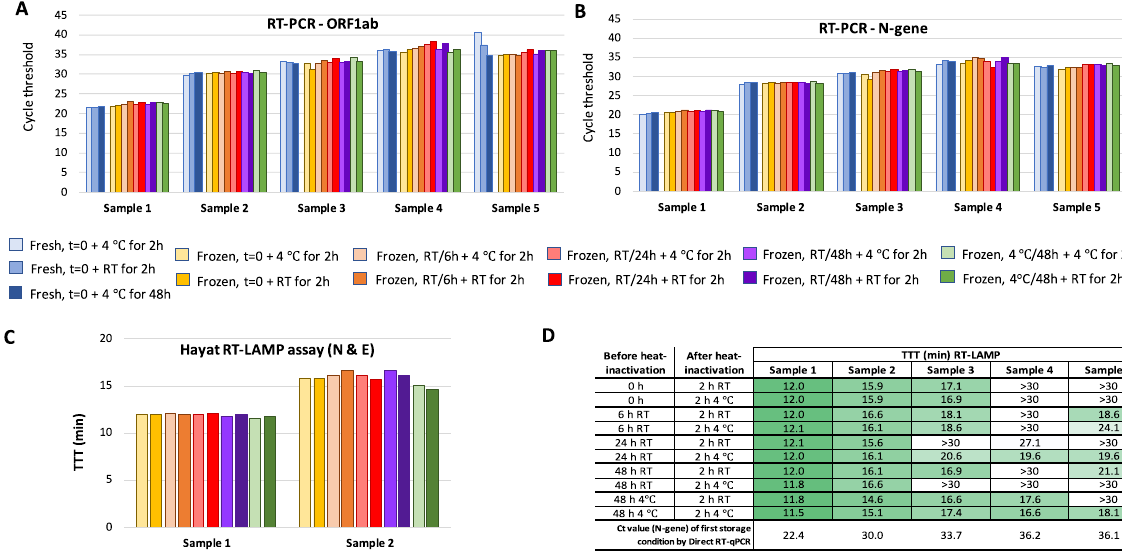
Figure 3. Stability of saliva samples during short-term storage determined by RT-PCR and RT-LAMP. Five sample pools were prepared from ten saliva samples to give a range of viral loads corresponding to predicted Ct values (from extracted RNA) from 24.6 to 35.0 for the N-gene and 25.8 to 39.1 for ORF1ab. Sample pools were diluted with an equal volume of AviSal buffer and stored short-term under the following test conditions prior to heat inactivation: room temperature (RT) for 0, 6, 24 and 48 h (t = 0, 6 h, 24 h and 48 h) or 4 °C for 48 h. Samples were then heat inactivated at 95 °C for 10 min and frozen. Upon thawing, samples were stored post inactivation at either 4 °C or RT for 2 h or 4 °C for 48 h (t = 0 only). The 4 °C incubation was taken as baseline as a proxy for no post-inactivation storage. RT-PCR (BGI Real-Time Fluorescent RT-PCR Kit for Detecting SARS-CoV-2), targeting ORF1ab ( A ) and the N gene ( B ), and RT-LAMP (Hayat Genetics) ( C , D ) assays were performed on samples subjected to each of these conditions. To understand the effect of freezing samples prior to heat inactivation, for the t = 0 timepoint, a fresh versus frozen comparison was performed. Viral loads (as measured by RT-PCR on extracted RNA) of sample pools #3, 4 and 5 are too low for 100% sensitivity of detection by RT-LAMP—all have Ct ≥ 33 for N gene. Hence, not all reactions were positive within the 30 min runtime ( D ). All Ct (Cycle Threshold) and TTT (Time to Threshold) values were calculated as the mean of technical